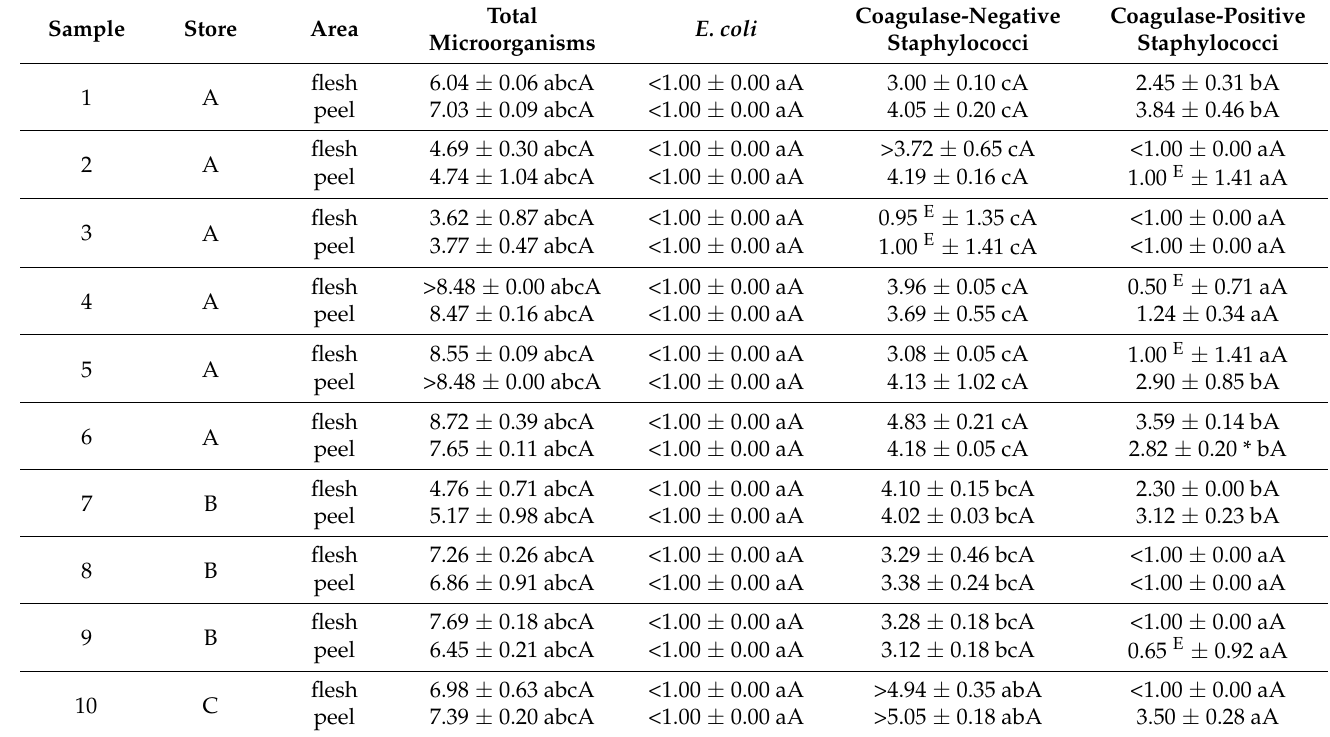
Table 1. Microbiological analysis (log CFU/g) of surface and peel of cut